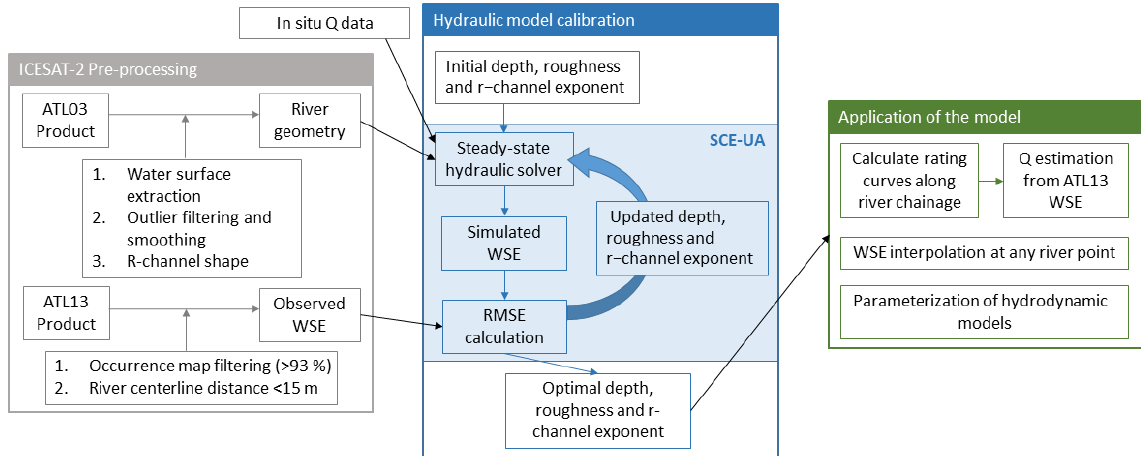
Figure 2. Schematic diagram of the data processing and modeling workflow in this study. The methodology proposes a series of applications from a calibrated